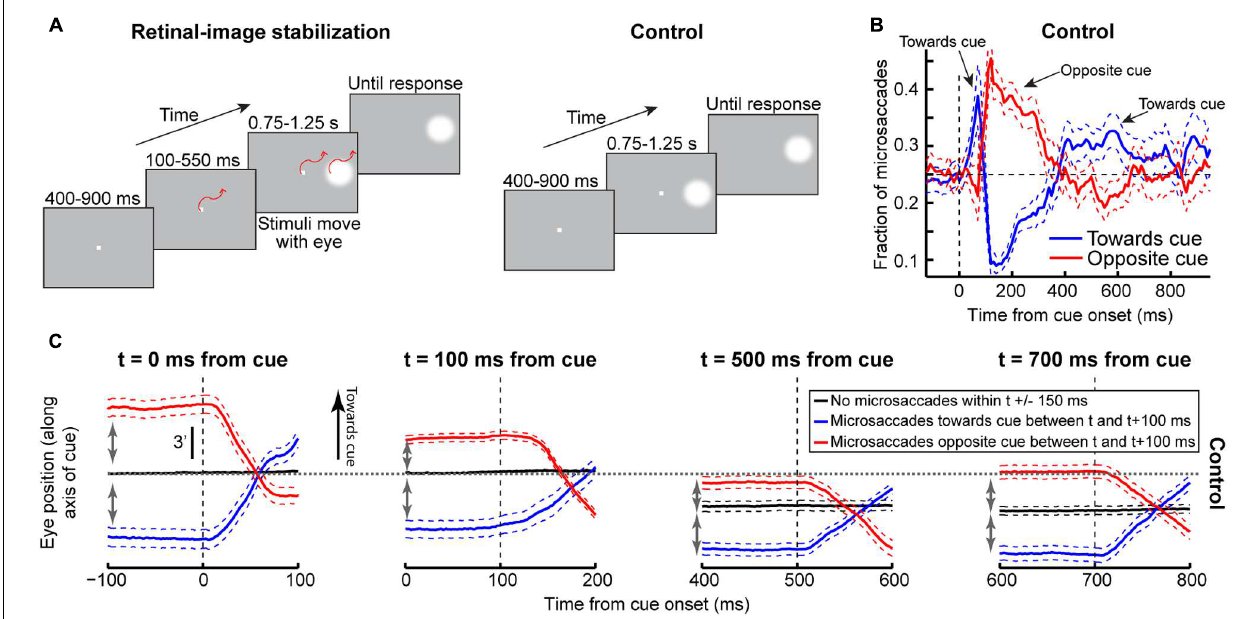
FIGURE 10 | Understanding why post-cue microsaccades directionally oscillate. (A) Cue onset with retinal-image stabilization was compared to a control condition (see Materials and Methods). (B) The proportion of microsaccades in the control condition whose directions were < 45 ◦ from the direction of the cue (blue) or opposite it (red). Microsaccades oscillated as in Figure 4 . Error bars denote 95% confidence intervals. (C) We hypothesized that these oscillations primarily reflected eye-position error corrections. We thus analyzed such error at different times. For each time t , we measured average eye position when there were no microsaccades within t ± 150 ms. This was deemed the preferred retinal locus during stable fixation at t (black). We then measured average eye position when there were microsaccades between t and t + 100 ms toward (blue) or opposite (red) the cue. Regardless of t , microsaccades toward the cue occurred when previous eye position error from the preferred retinal locus was away from the cue (compare blue to black in the interval before t ); microsaccades opposite the cue occurred when previous eye position error was toward the cue (compare red to black). This held when most microsaccades according to (B) were either toward the cue ( t = 0 ms), opposite the cue ( t = 100 ms), or not particularly directional (later t ’s). Figure 11 provides a reason for why microsaccades oscillated despite being predominantly corrective. Error bars denote